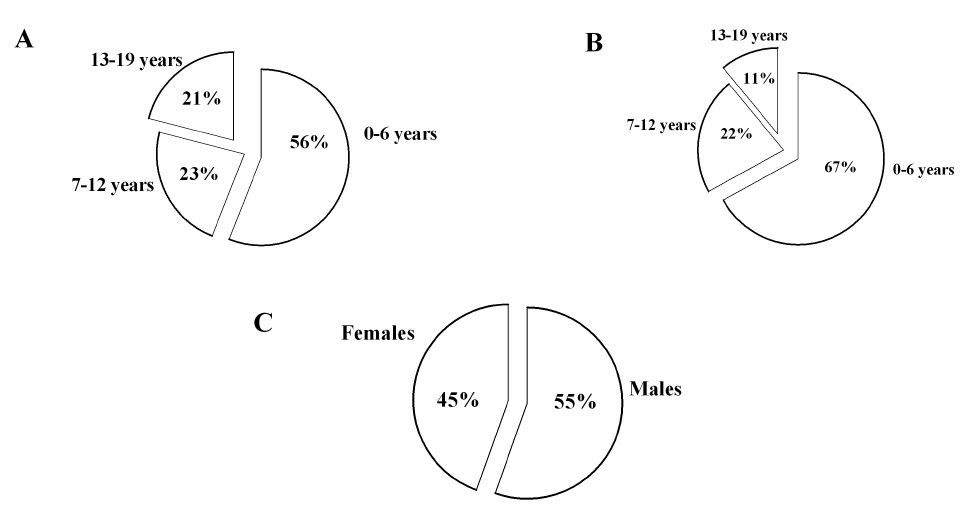
Figure 3. Prevalence for age ( A ), incidence for age ( B ), and prevalence for gender ( C ).